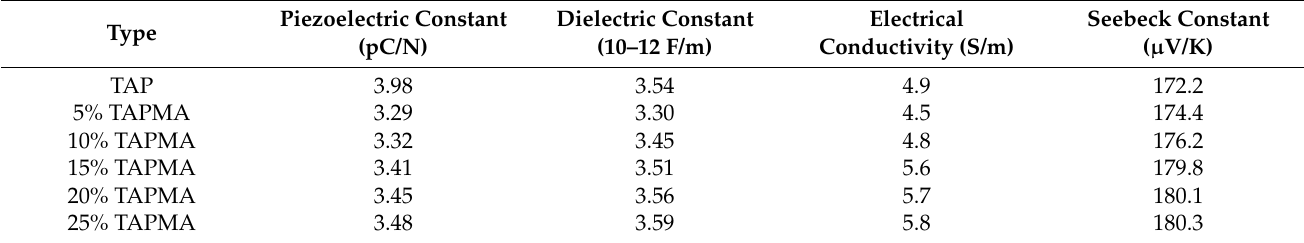
Table 5. Piezoelectric and thermoelectric properties of TAP and TAPMA.